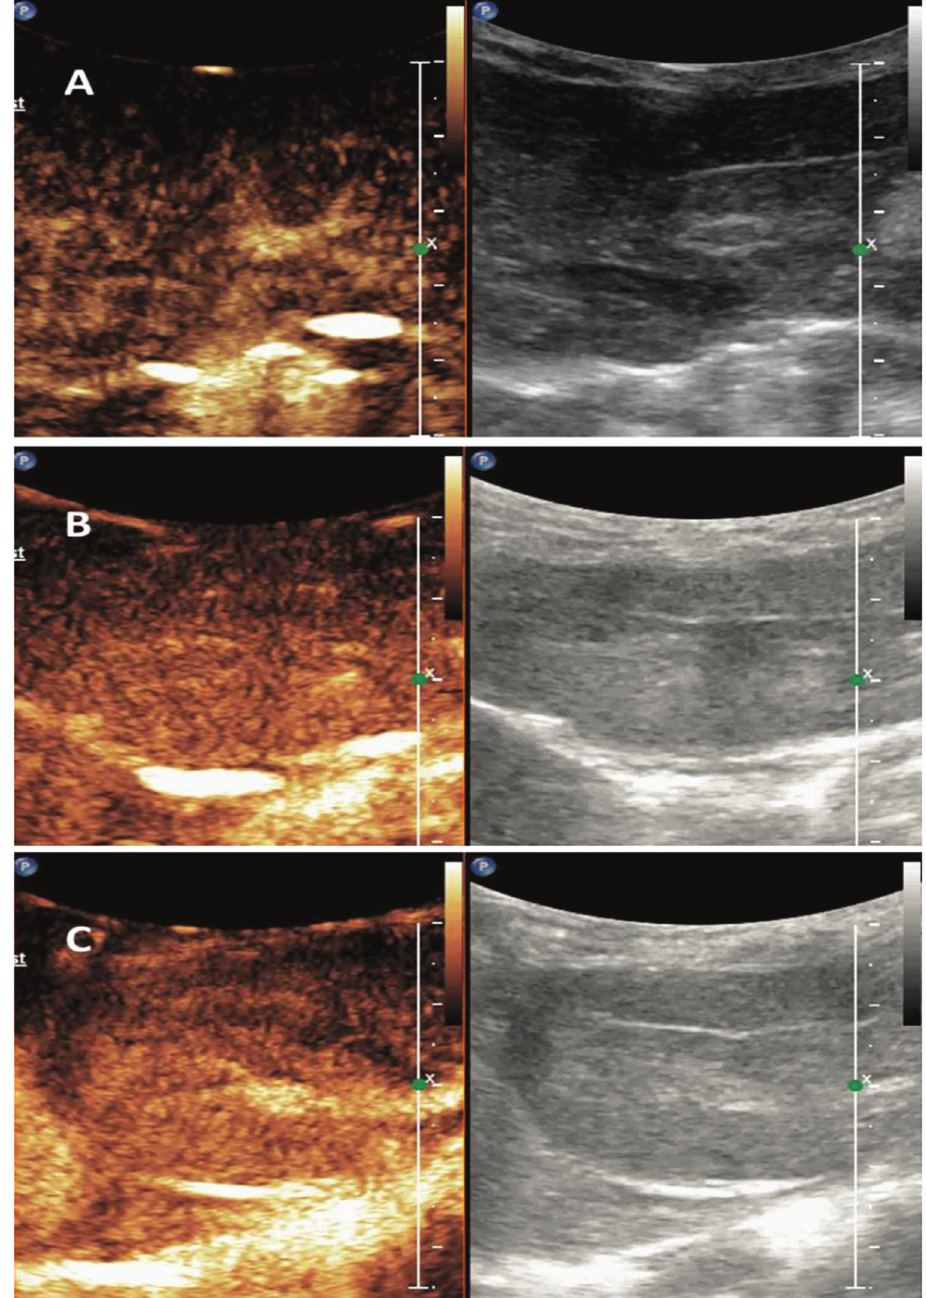
Figure 2. Hepatic perfusion imaging of different contrast agent perfusion rates. The 3 (cid:1) 10 8 bubbles/min ( B ) and 4 (cid:1) 10 8 bubbles/min ( C ) perfusion rates showed better enhancement than 2 (cid:1) 10 8 bubbles/min ( A ). Additional tests showed that the 3 (cid:1) 10 8 bubbles/min perfusion rate was superior to the 4 (cid:1) 10 8 bubbles/min perfusion rate in image enhancement and